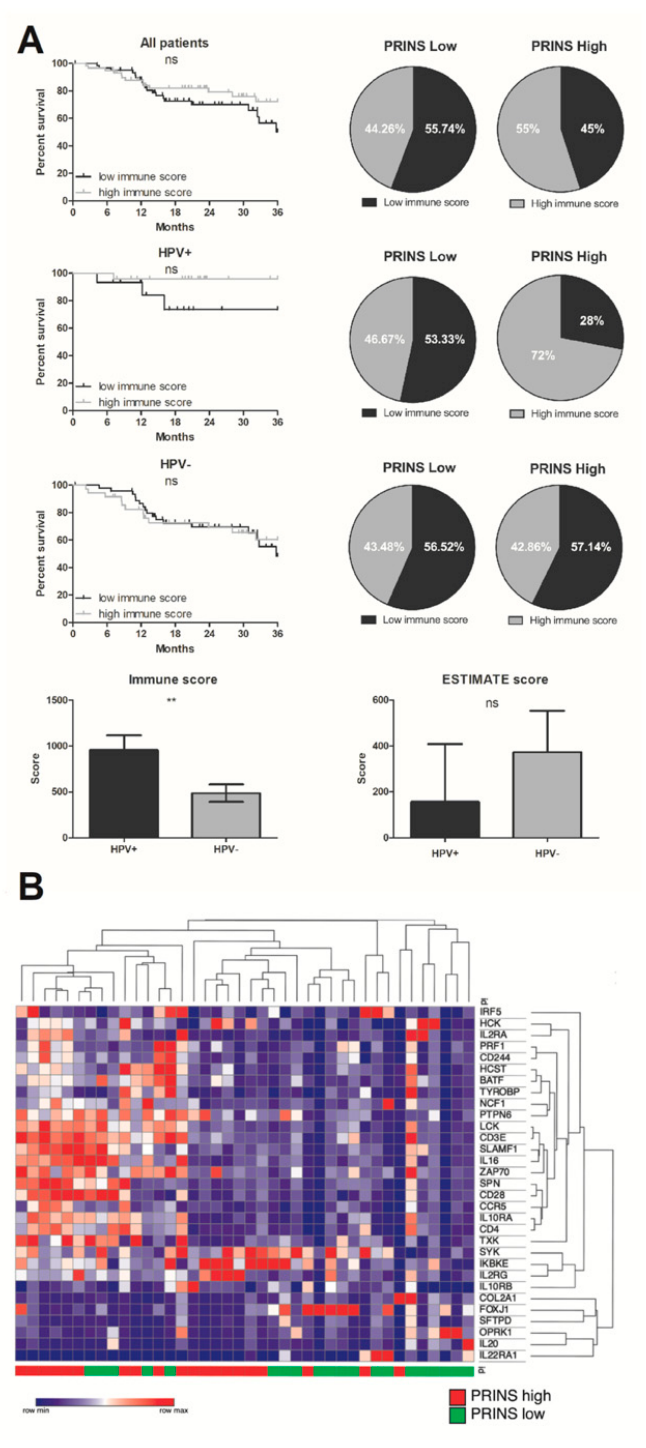
Figure 5. PRINS a ff ects immunophenotype of HNSCC patients; ( A ) OS in all patients (HPV( + ) and HPV( − )), HPV( + ) and HPV( − ) with high and low immune scores based on ESTIMATE tool (Estimation of Stromal and Immune cells in MALignant Tumor tissues), and the percentage of patients with high and low immune scores within the low and high PRINS expression groups; ( B ) heat map and clustering of immune regulatory related genes significantly changed ( p < 0.05) in low and high PRINS groups of HPV( + ) HNSCC patients. The graphs show median values with SEM. Ns: not significant, ** p <